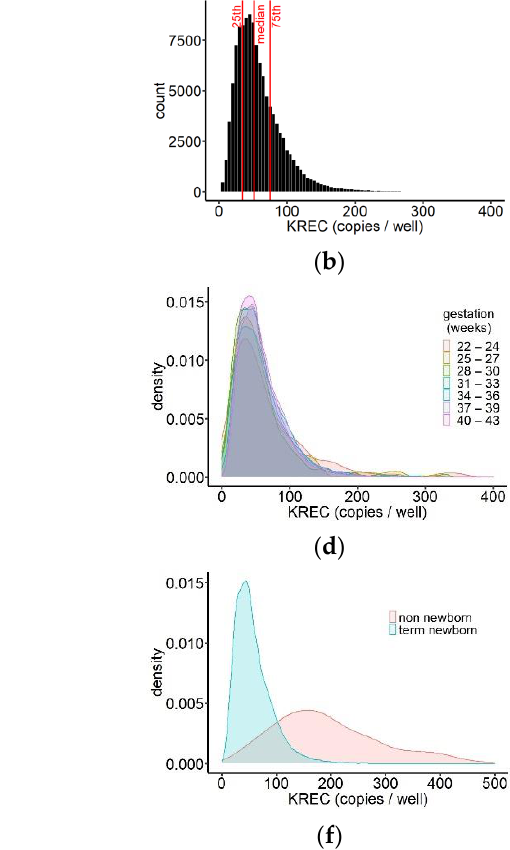
Table 1. Median TREC and KREC values in children of different gestational ages.